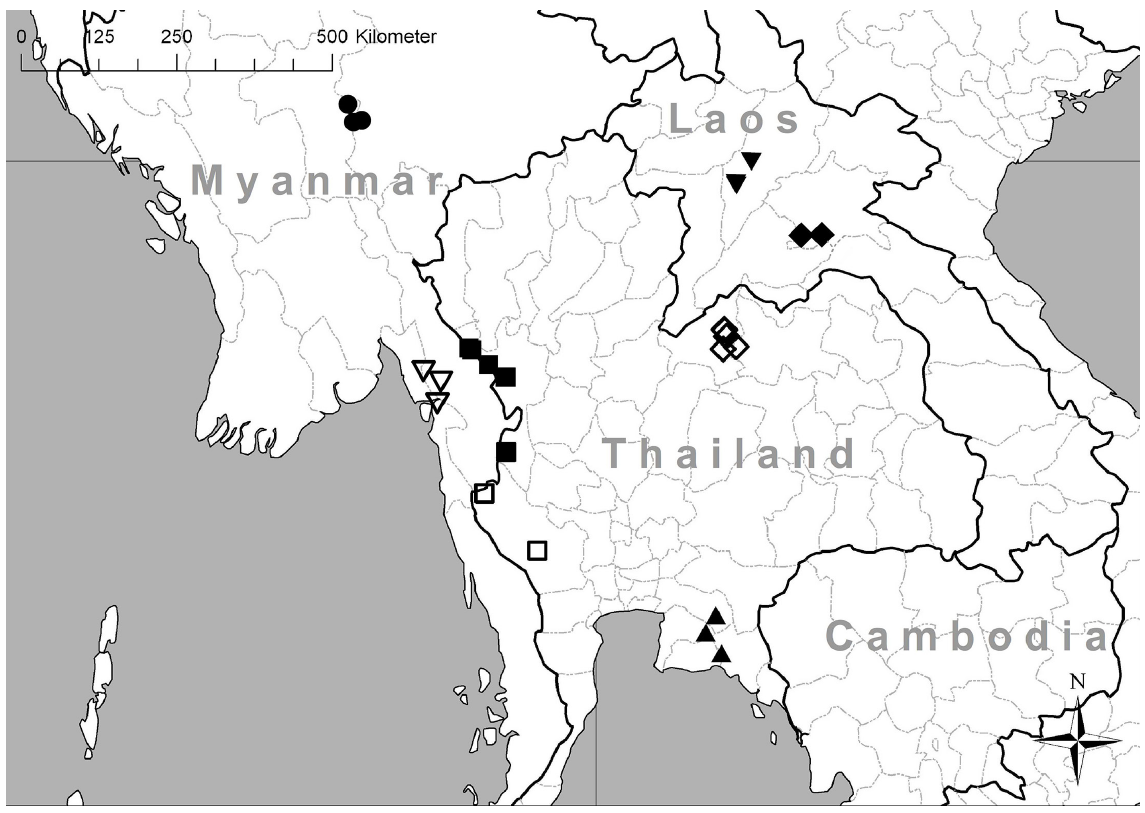
Fig. 12. Distribution of plectopylid species in Thailand, Laos and Myanmar. Legends: circle = Chersaecia shanensis (Stoliczka, 1873); filled square = Chersaecia reversalis sp. nov.; empty square = Chersaecia dextrorsa (Benson, 1860); empty rhomb = Hunyadiscus tigrina sp. nov.; filled rhomb = Hunyadiscus saurini Páll-Gergely, 2016; triangle, top up = Plectopylis crassilabris sp. nov.; triangle, top down = Naggsia laomontana (L. Pfeiffer, 1862); empty triangle, top down = Plectopylis bensoni Gude,